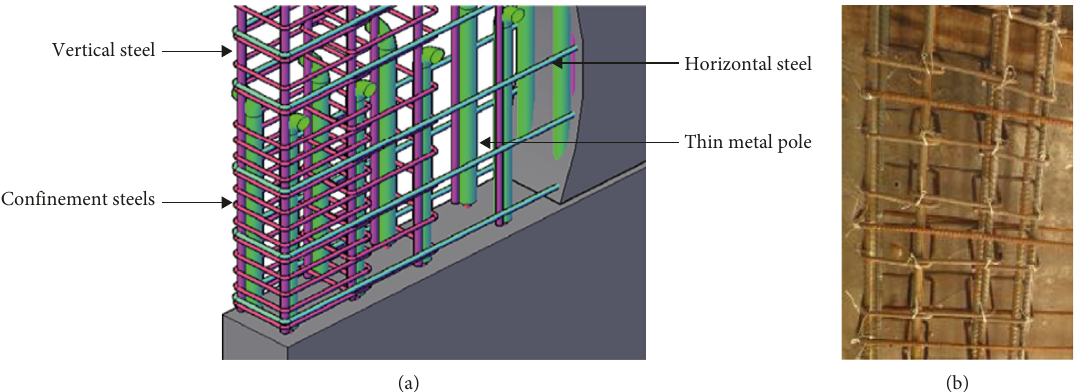
Figure 1: The NPGCS steel bars configuration. (a) Steel bars configurations. (b) Steel bars configurations in